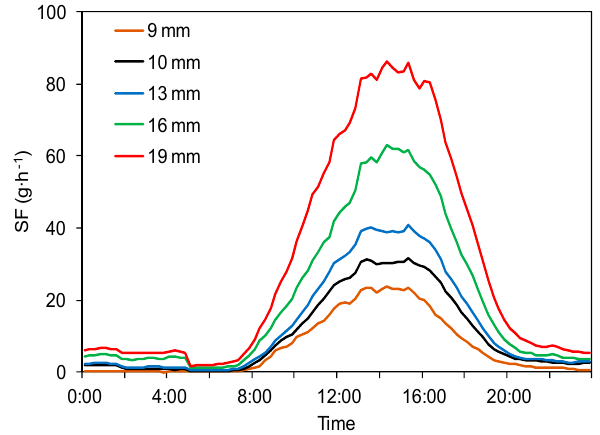
Figure A3. Dynamics of sap flow (SF) for ( a ) air temperature (T), ( b ) photosynthetically active radiation (PAR), ( c ) vapor pressure deficit (VPD), ( d ) variable of transpiration (VT), and ( e ) reference evapotranspiration (ET 0 ).